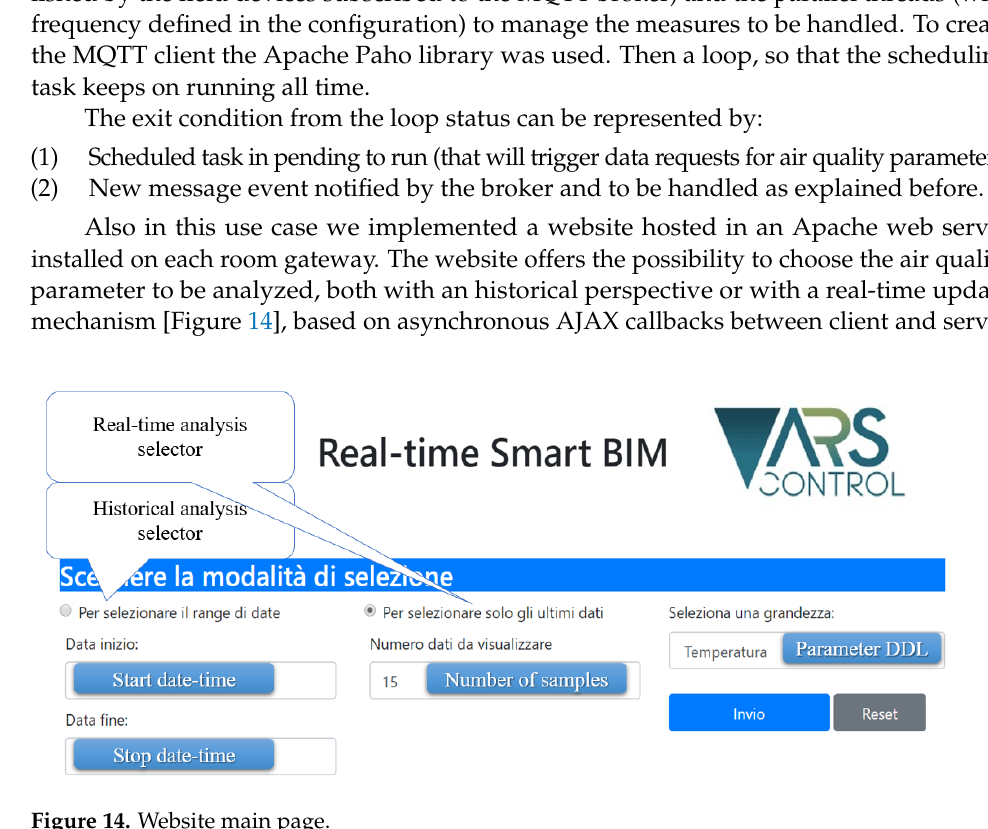
Figure 14. Website main